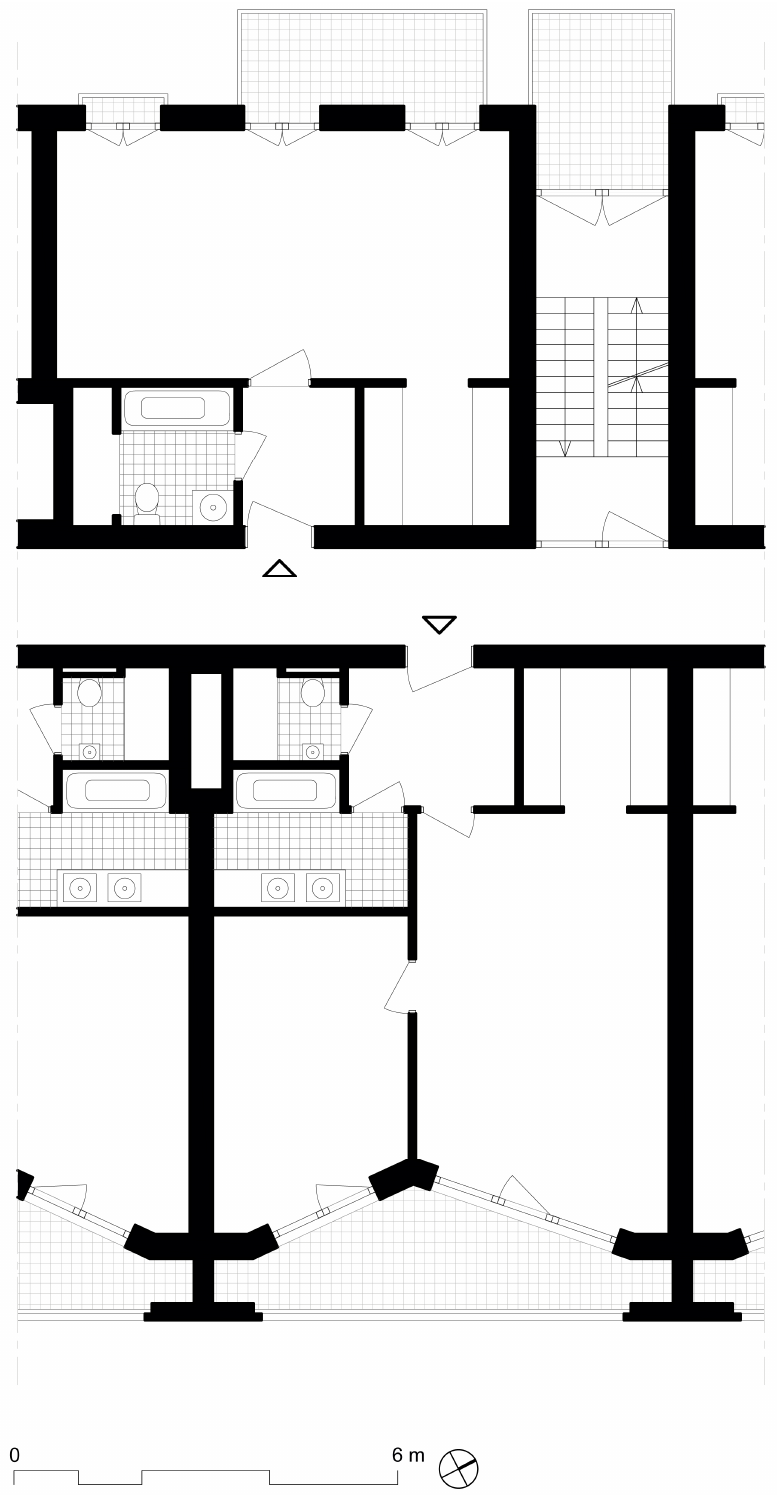
Figure 8. Dwelling plan of the project “Bpost” by 51N4E (re-drawing by the authors).